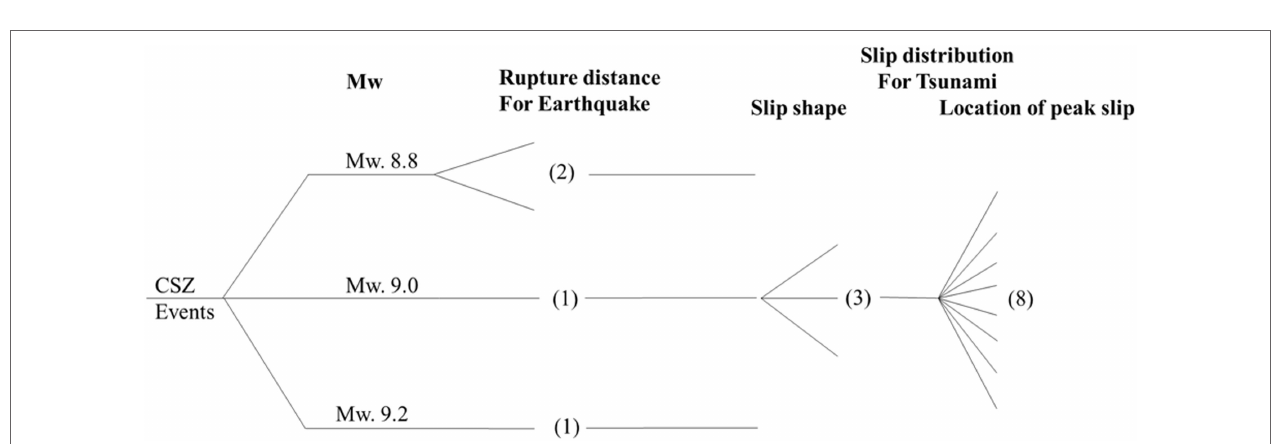
FIGURE 5 | Study area of Seaside, Oregon, at the landward side of the C-Grid shown in Figure 4 . (A) Satellite image of the City of Seaside area with Necanicum River and Neawanna Creek bisecting the city. Areas marked by 1 (circle), 2 (square), and 3 (triangle) are example locations used in later figures. Red box highlights detailed area in later figures. (B) Bathymetry/topography for study area. Note that waterfront area of the city is built on a remnant dune and has higher elevation than river areas. (C) Soil classes assumed based on DOGAMI Oregon Department of Geology and Mineral Industries (2017) maps.